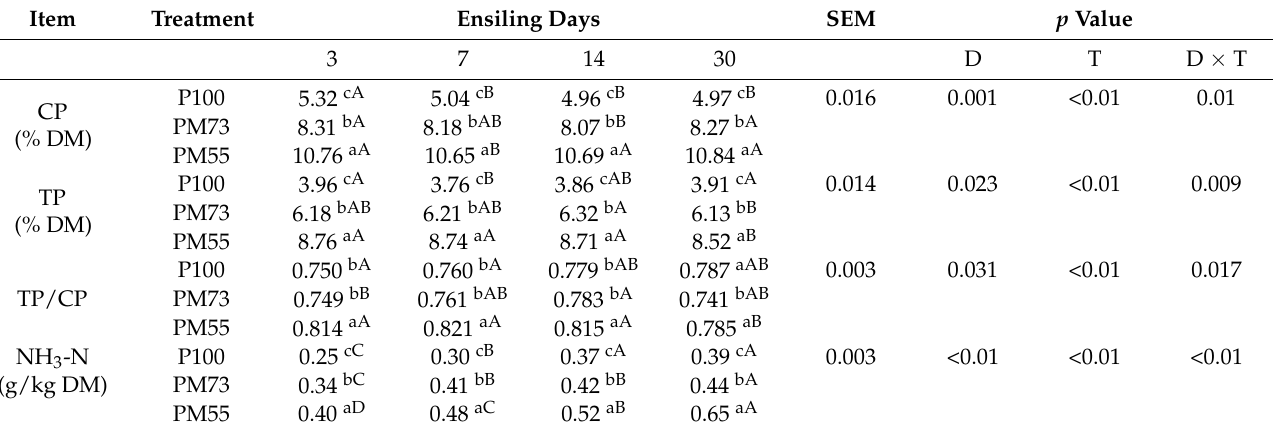
Table 3. The protein fraction of mulberry leaves and hybrid Pennisetum